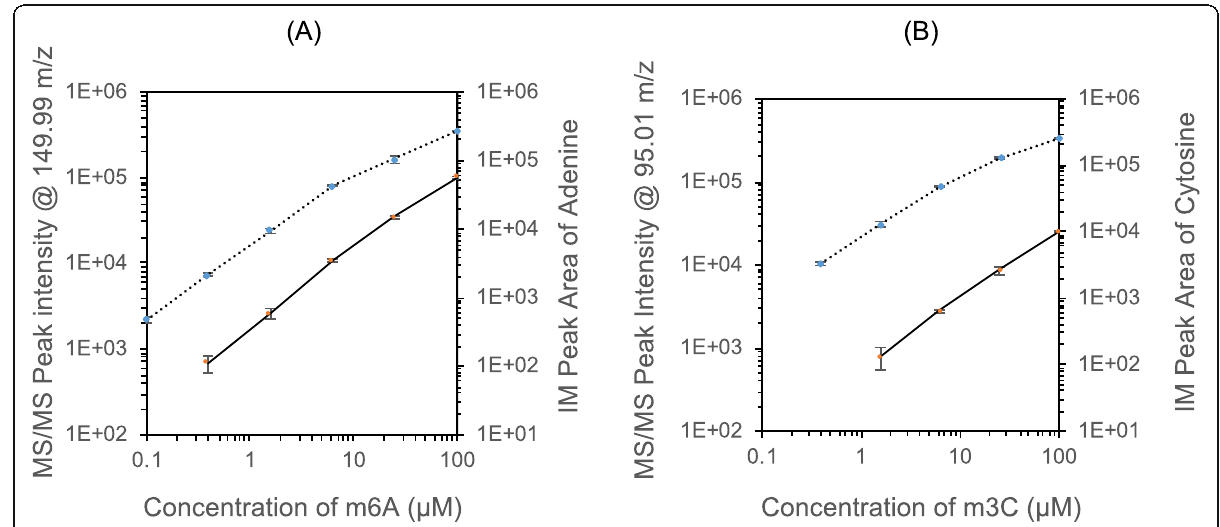
Fig. 6 Calibration graphs of ( a ) m6A and ( b ) m3C using the SRI method. The MS/MS data (solid line) of a specific post-IM CID fragment ion or the IM data (dotted line) of corresponding methylated nucleobase are plotted against the concentration of methylated ribonucleoside in standard dilution. The error bars represent one standard deviation ( n =